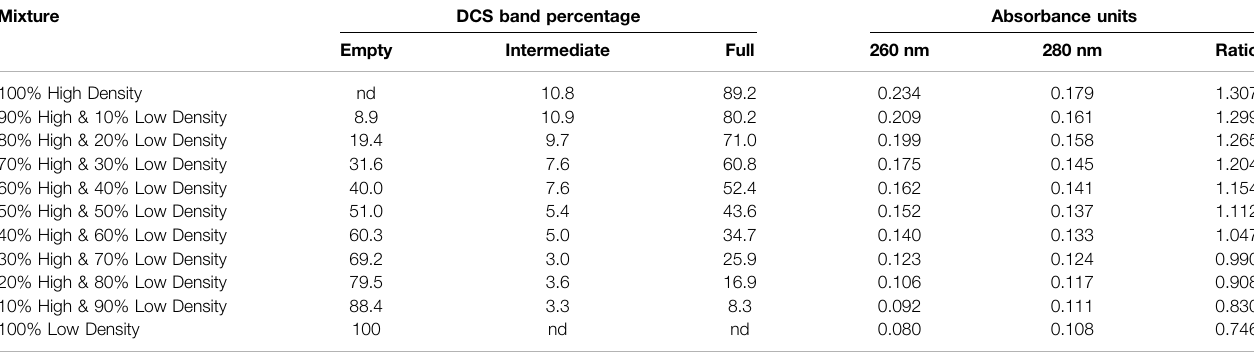
TABLE 3 | Differential Centrifugation Sedimentation analyses and 260/280 absorbance measurements of AdC68 #1 low/high density viral particle fractions as well as mixtures of said fractions. Mixture DCS band